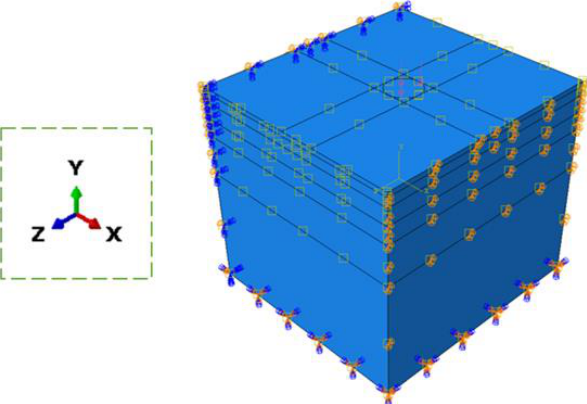
Figure 3. The pavement model with structural boundary conditions.